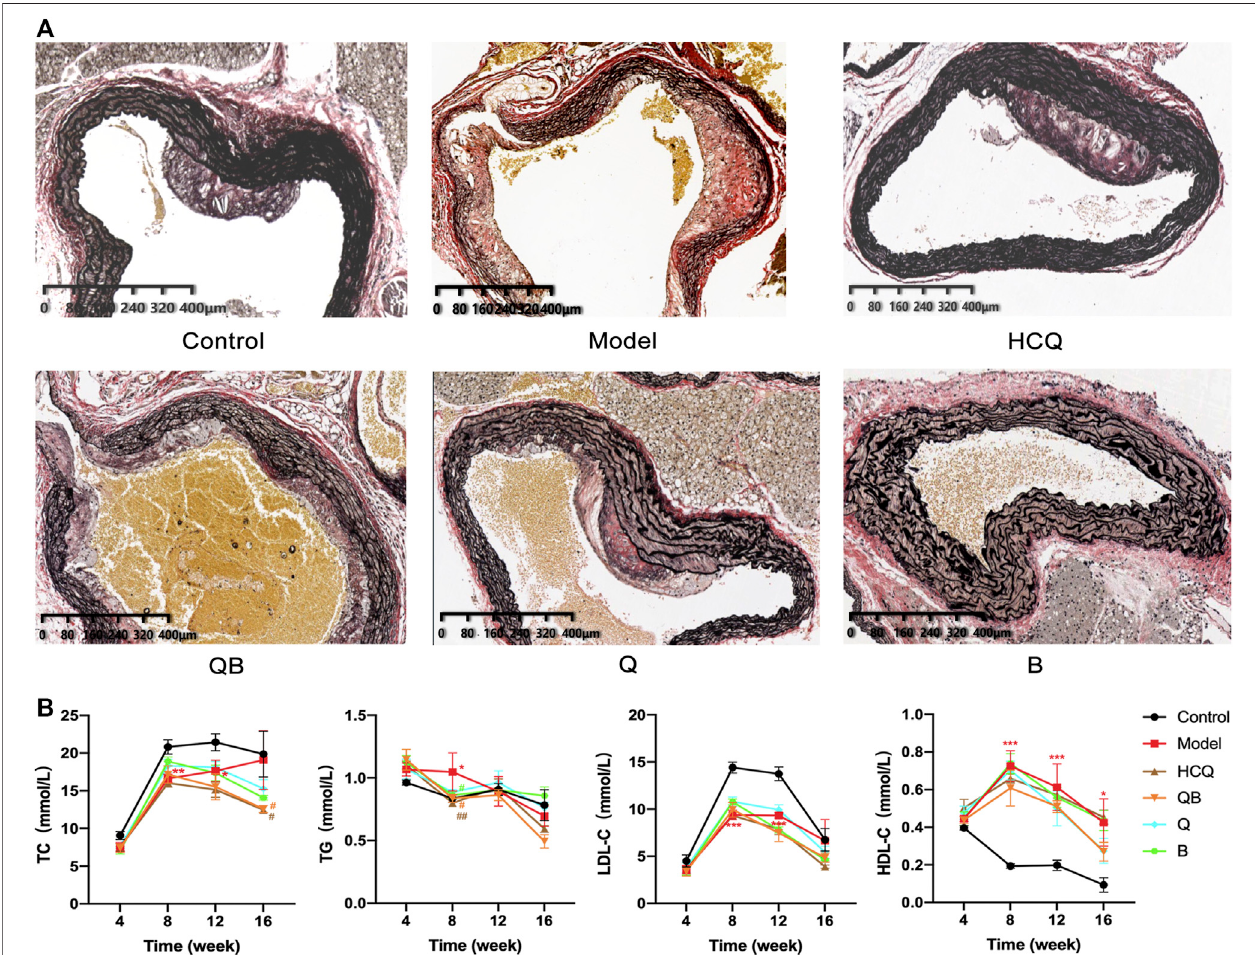
FIGURE 4 | Effect of Qinghao-Biejia on aortic atherosclerosis and lipid metabolism in serum. (A) Representative images of EVG staining of aortic. (B) The level of total cholesterol (TC), triglyceride (TG), low density lipoprotein cholesterol (LDL-C) and high density lipoprotein cholesterol (HDL-C) in serum. The data are expressed as the mean ± SEM. Model group compared with the control group, * p < 0.05, ** p < 0.01, *** p < 0.001; the remaining groups compared with the model group, # p < 0.05, ## p <